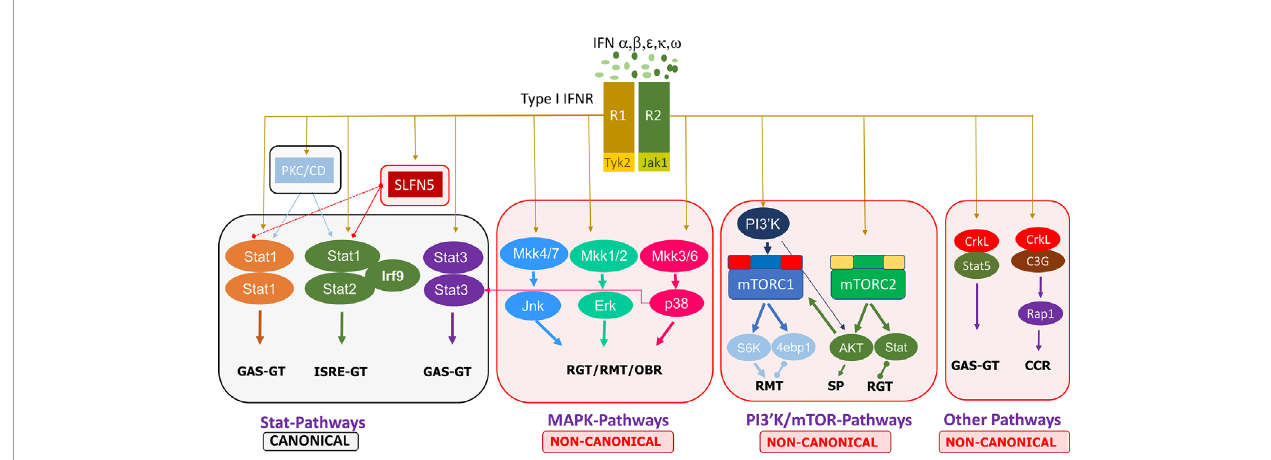
FIGURE 1 | Summary of the canonical and non-canonical pathways involved in type I interferon signaling. 4ebp1, eukaryotic translation initiation factor 4E binding protein 1; CCR, cell cycle regulation; ERK, extracellular signal-regulated kinase; GAS, gamma-activated sequence; GT, gene transcription; IFN, interferon; IFNR, interferon receptor; IRF, interferon regulatory factor; ISRE, interferon-stimulated response element; JAK, janus kinase; Jnk, c-Jun N-terminal kinase; MKK, mitogen activated protein kinase kinase; mTORC, mammalian target of rapamycin complex; PI3 ′ K, phosphoinositide 3-kinase; PKC, protein kinase C; CD, Calmodulin- dependent kinase, R1/R2, receptor 1/2; Rap, Ras-related protein; RGT, regulation of gene transcription; RMT, regulation of mRNA translation; OBR, other biological responses; S6K, ribosomal protein S6 kinase; SLFN, Schlafen; STAT, signal transducer and activator of transcription; SP, survival